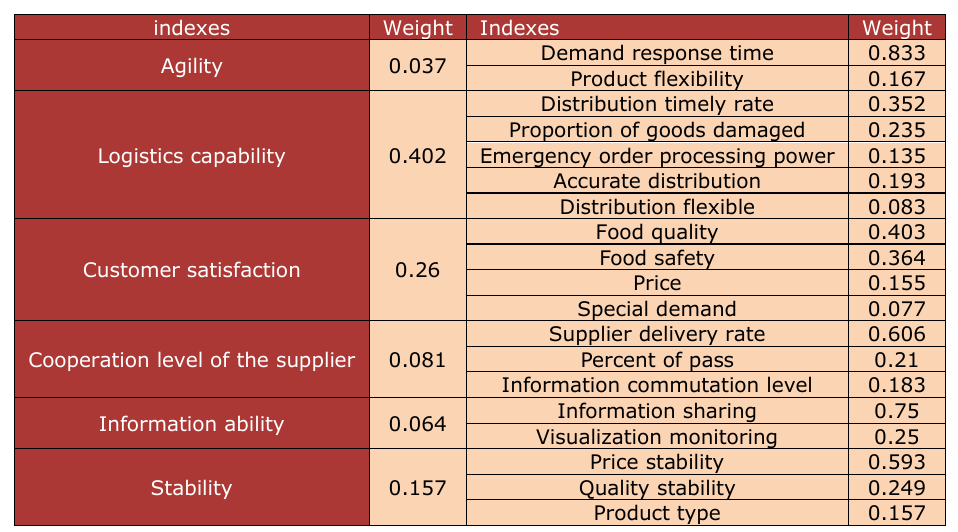
Table 5 . Relative weight of vendor evaluation